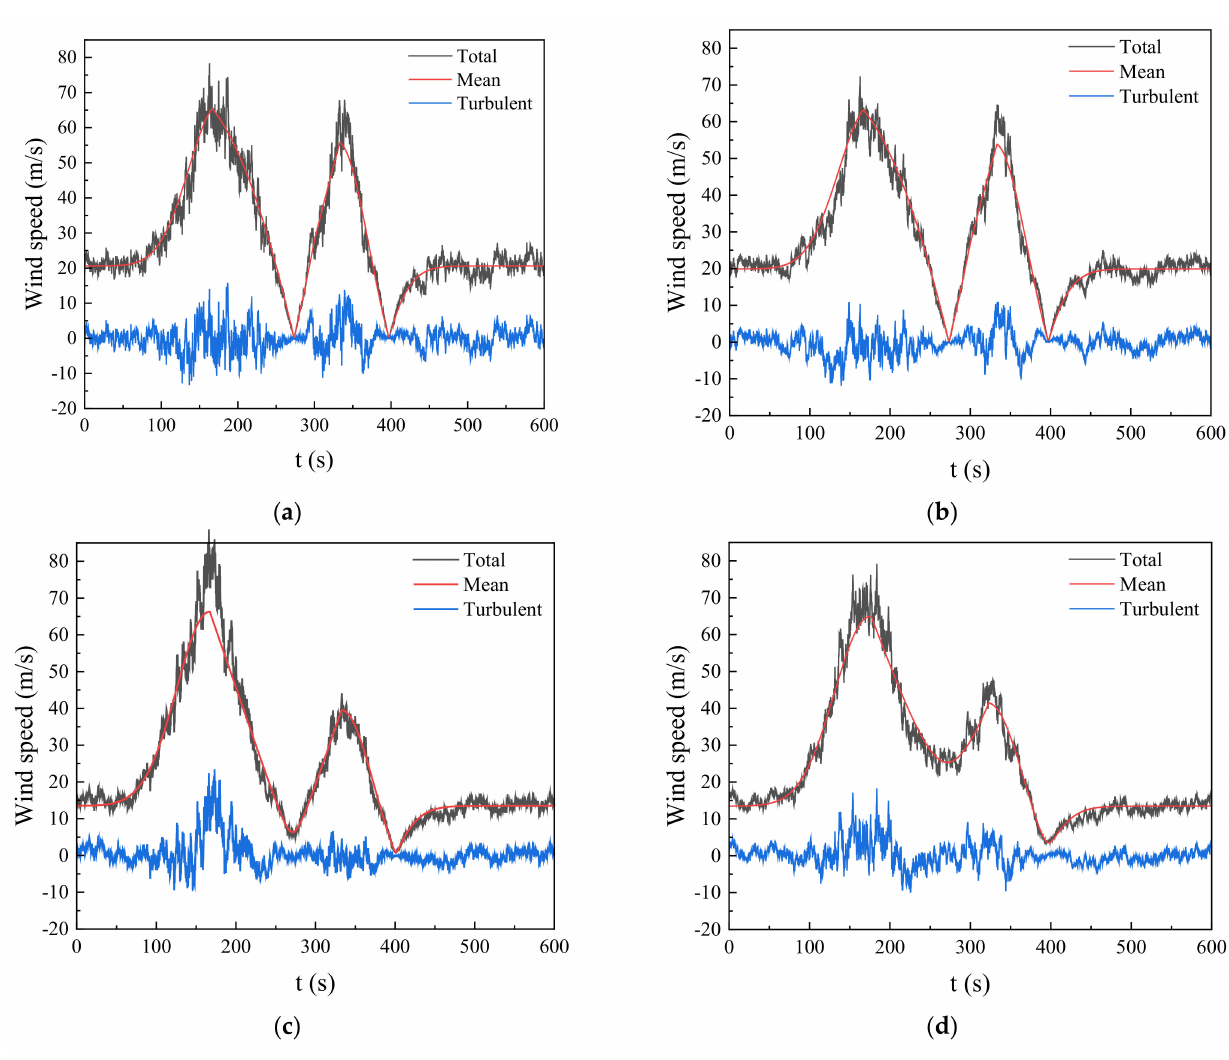
Figure 6. Wind speed time history of simulation points: ( a ) P1; ( b ) P2; ( c ) P3; ( d )